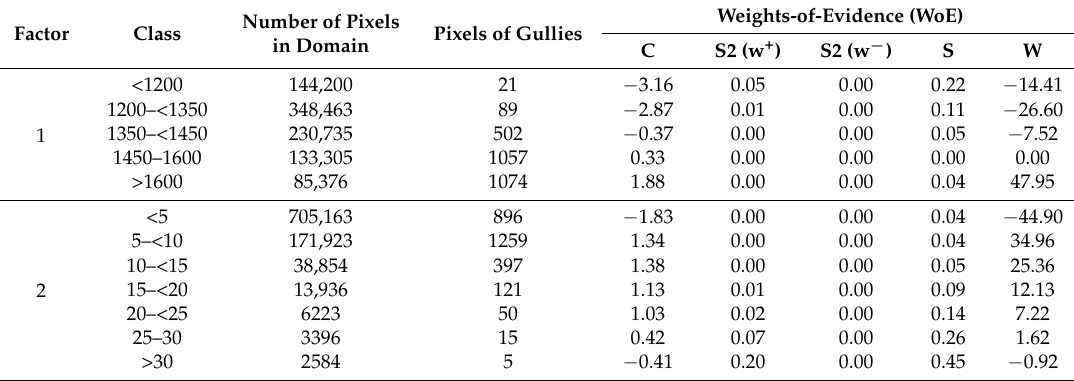
Table 3. Relationship between conditioning factors and gully erosion using weights-of-evidence (WoE)